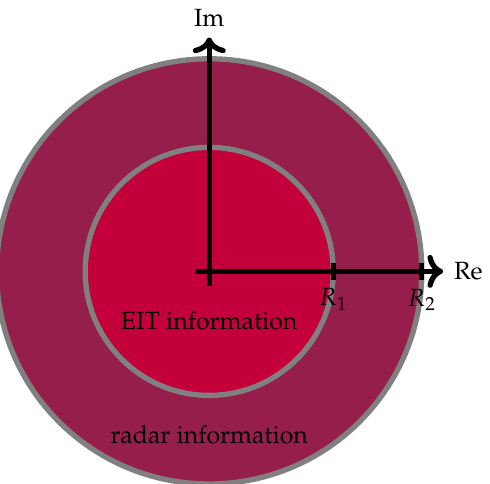
Figure 7. Visualization of the merging in the k-space. The purple area represents the k-space that is filled with t radar ( k ) , while the red area is filled with t EIT ( k ) . Values outside